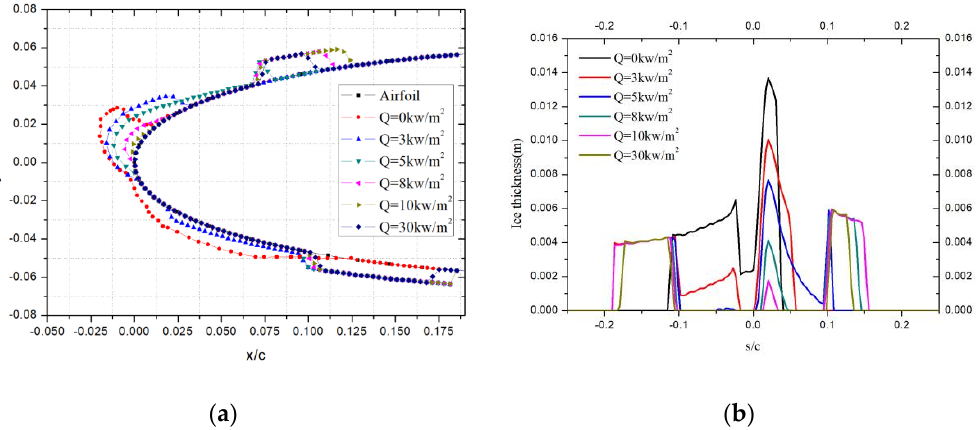
Figure 6. Icing characteristics with protection range of s / c = ± 0.1: ( a ) Ice shapes; ( b ) Ice thickness.